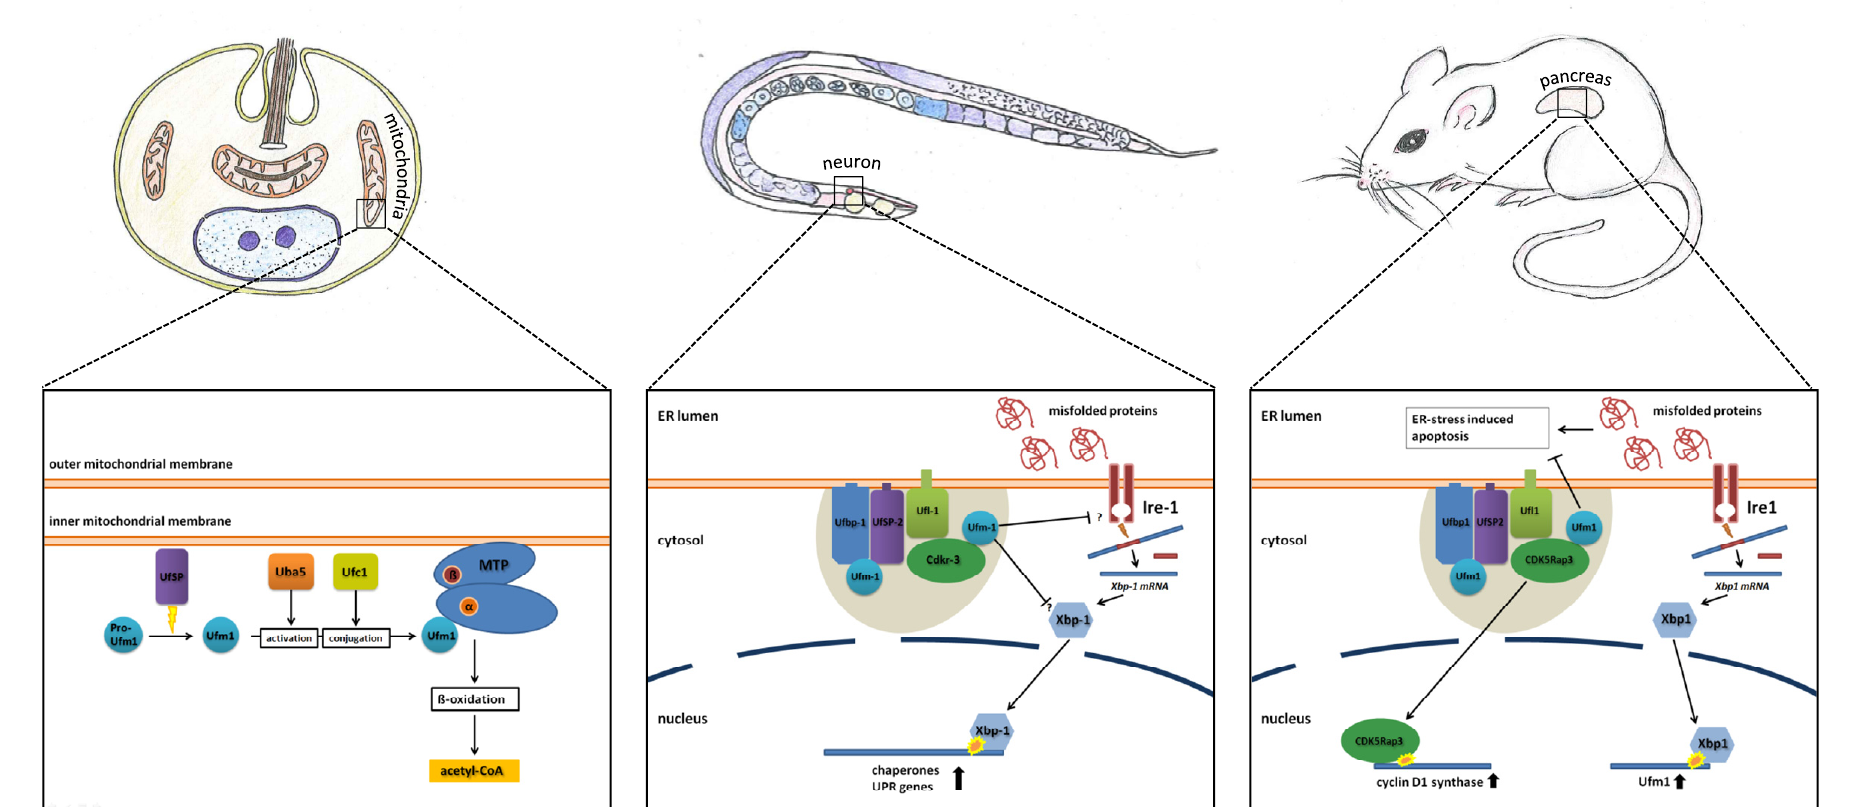
Figure 2. Simplified model of the known functions of the Ufm1 cascade in L. donovani , C. elegans and mammals. The known implications of the Ufm1 cascade are discussed in the